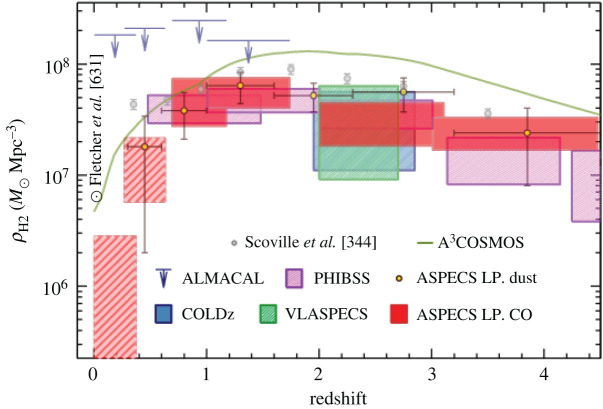
The redshift evolution of the cosmic molecular gas mass density, ρH2(z), obtained by Decarli et al. [629], using CO detections from the ASPECS Large Programme 1 and 3 mm scans (red shaded regions; [78]). Results from another molecular line scan, the VLA COLDz survey [630], are shown in blue. The yellow circles show the evolution of gas density also from the ASPECS-LP, but where the gas masses are inferred from dust continuum observations [418]. Also for comparison, constraints from other targeted and archival surveys are shown: VLASPECS (a VLA follow-up of ASPECS sources; [631]), PHIBSS (targeted CO and dust continuum in massive galaxies; [345]), ALMACAL (via CO absorption towards distant quasars; [304]), A3COSMOS (archival observations; [346]) and the Scoville et al. [344] survey of dust continuum in galaxies. The local measurement from the IRAM xCOLD GAS survey [632] is shown as a black circle. Figure courtesy of Decarli et al. [629].